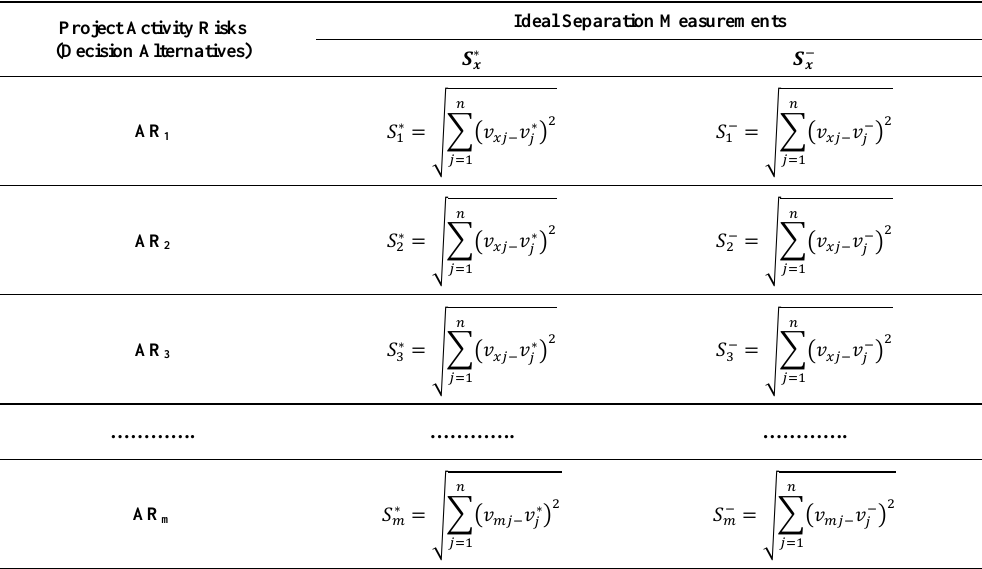
Table 4. Ideal separation